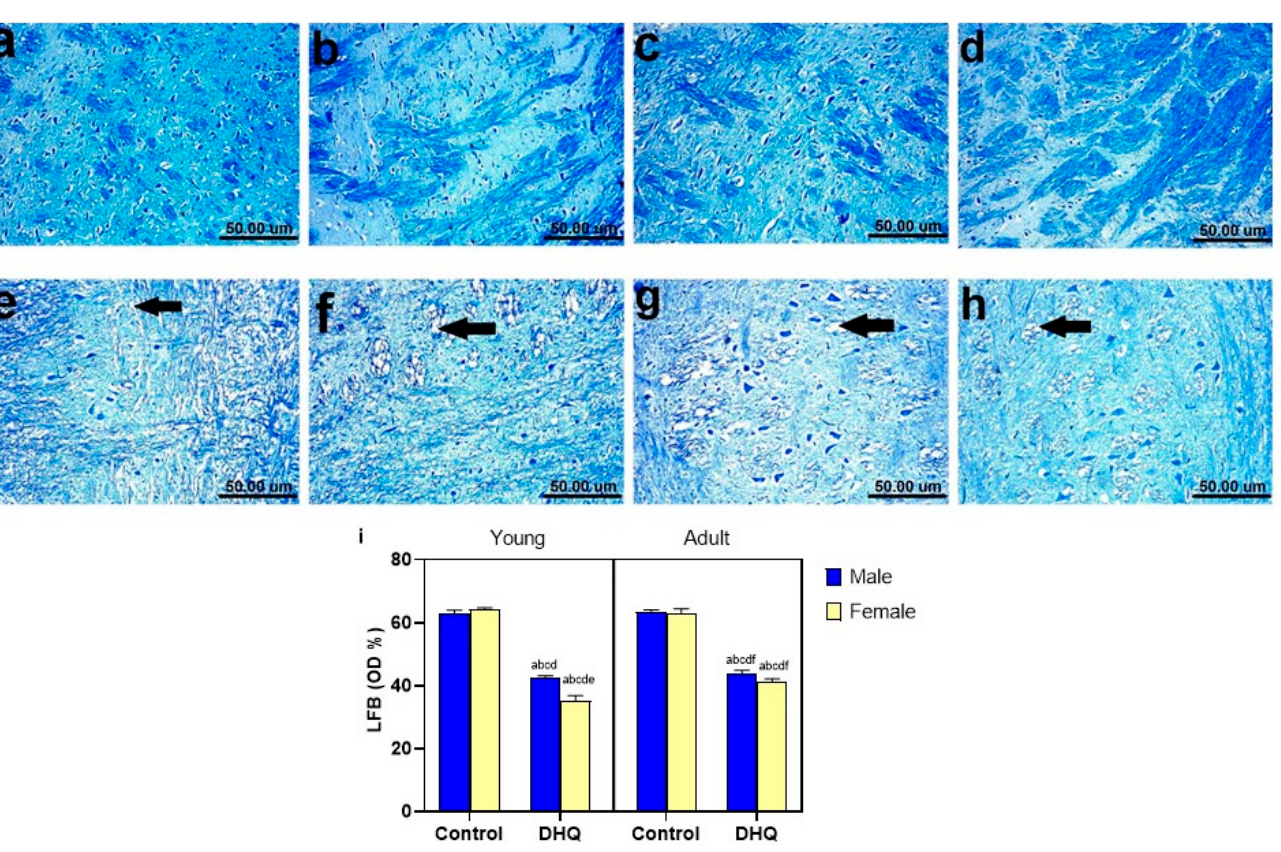
Figure 9. Histological Luxol fast blue-stained sections from striatum of ( a – d ) control rats, ( a ) young male, ( b ) young female, ( c ) adult male, and ( d ) adult female, showing apparently normal dark blue myelinated axons. ( e–h ) showing demyelination (black arrow), ( e ) DHQ young male, ( f ) DHQ young female, ( g ) DHQ adult male, and ( h ) DHQ adult female. (Scale bar 50 um). ( i ) Quantitative analysis of LFB staining in striatal sections. Each bar with a vertical line represents the mean ± S.D. of 5 rats per group (5 fields/rat). a vs. control young male, b vs. control young female, c vs. control adult male, d vs. control adult female, e vs. DHQ young male, and f vs. DHQ young female, using three-way ANOVA followed by Tukey’s post hoc test; p < 0.05. DHQ; diiodohydroxyquinoline.